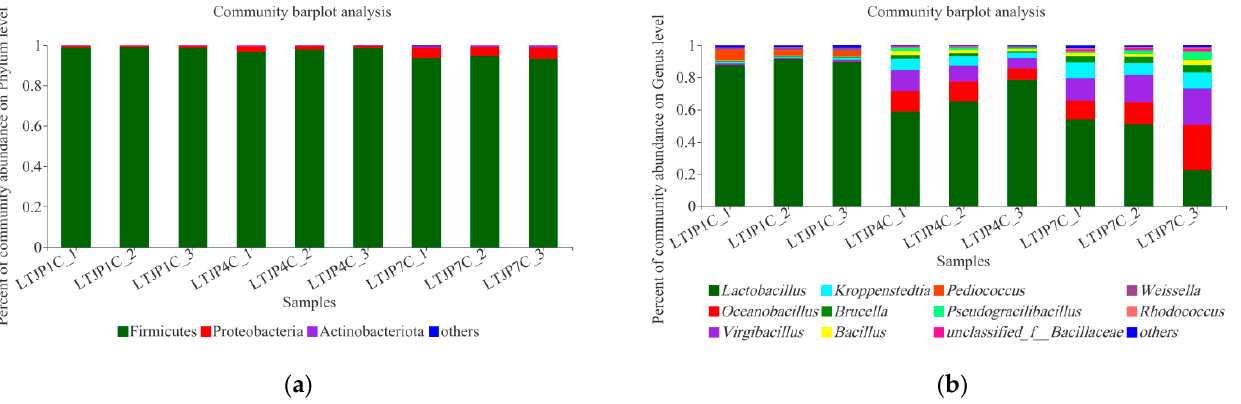
Figure 1. Dynamics of bacterial communities during baijiu fermentation at ( a ) phylum level and ( b ) genus level.